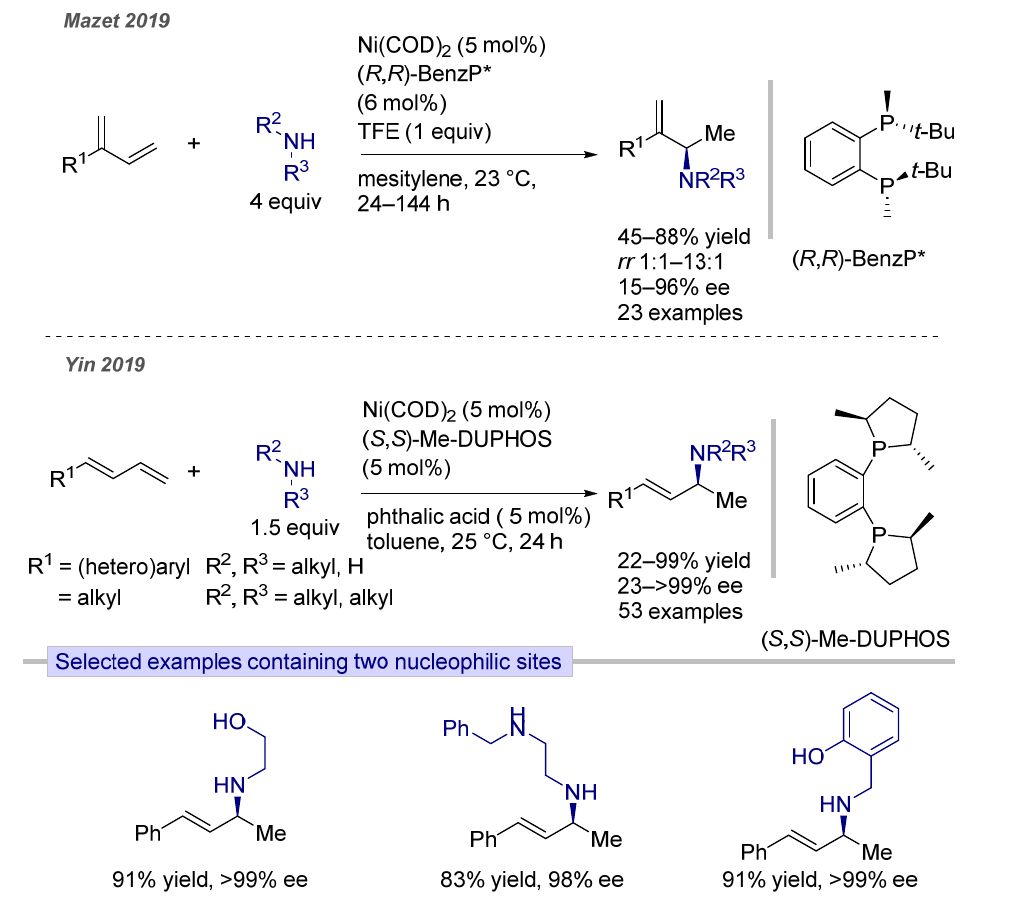
Figure 18. Regioselective Ni-catalyzed hydroamination of 2- and 1-substituted 1,3-dienes and primary and secondary amines. rr = regioselectivity defined as ratio 3,4-addition product vs. 1,4-addition products, ee = enantiomeric excess